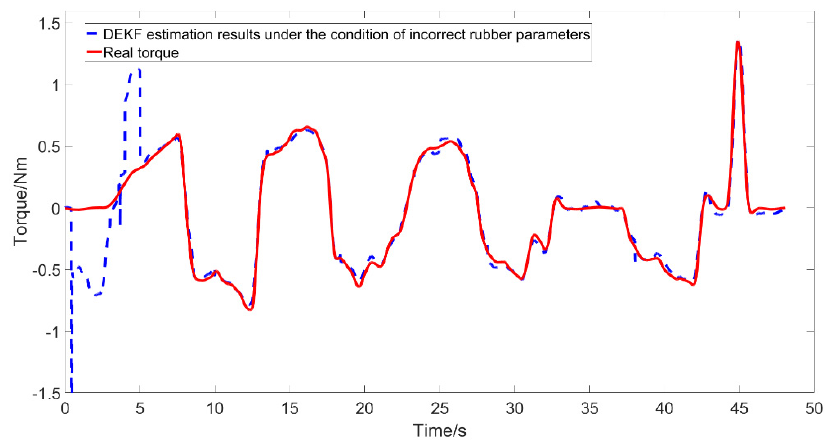
Figure 14. DEKF estimation results under the condition of incorrect rubber parameters.